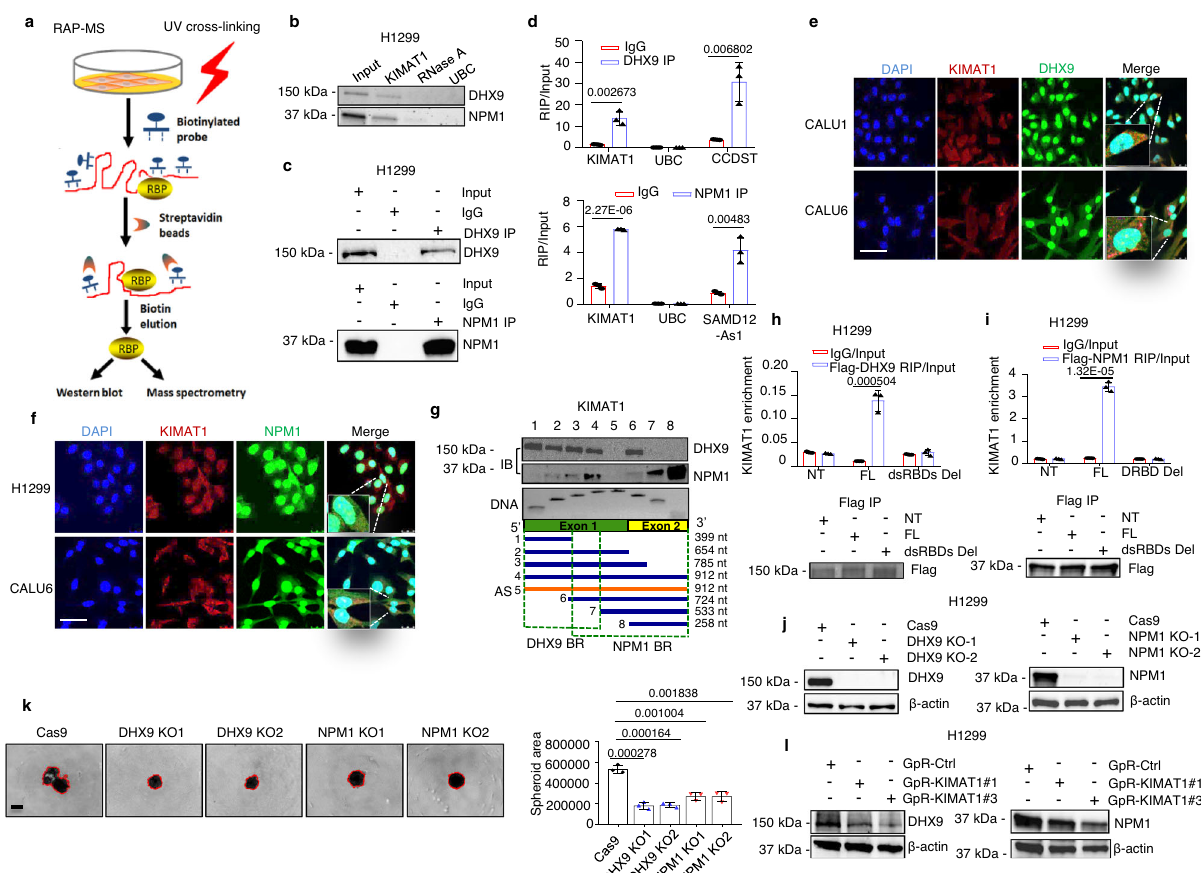
Fig. 4 KIMAT1 directly interacts with DHX9 and NPM1. a Schematic representation of RAP-MS. RBP = RNA-binding protein. b KIMAT1 pull-down with biotinylated antisense probes after UV crosslinking followed by immunoblotting analysis showing that DHX9 and NPM1 are direct KIMAT1 binding partners. A sample treated with RNase A or pull-down of the housekeeping gene UBC were used as negative controls. c Immunoblotting showing DHX9 and NPM1 pull-down ef fi ciency for the experiment in d . d KIMAT1 is enriched by CLIP assay using DHX9 or NPM1 speci fi c antibodies. e , f DHX9 and NPM1 sequential immuno fl uorescence (green) and KIMAT1 smFISH (Red) in different lung adenocarcinoma cell lines. Scale bar, 75 μ m. g Schematic representation of human KIMAT1 , its antisense (AS) and various deletion constructs generated to detect DHX9 or NPM1 binding regions in KIMAT1 sequence. Fragment sizes were con fi rmed by PCR (bottom panel), and binding of each fragment to DHX9 or NPM1 determined via pull-down of biotinylated-labeled RNA fragments and immunoblotting (IB) (top panels) with the indicated antibodies. BR binding region; nt nucleotide. h RNA immunoprecipitation assay. H1299 cells were transfected with FLAG-tagged full-length DHX9 (FL), or DHX9 without the two double-stranded RNA-binding domains (dsRBD Del) or Empty vector (NT), crosslinked and subjected to immunoprecipitation using FLAG-speci fi c antibody. (Top) DHX9-bound KIMAT1 was analyzed by qPCR. (Bottom) Immunoblotting showing immunoprecipitation ’ s ef fi ciency. i RNA immunoprecipitation assay. H1299 cells were transfected with FLAG-tagged full-length NPM1 (FL), or NPM1 without the RNA-binding domain (DRBD Del) or Empty vector (NT), crosslinked and subjected to immunoprecipitation with a FLAG-speci fi c antibody. (Top) NPM1-bound KIMAT1 was analyzed by qPCR. (Bottom) Immunoblotting showing immunoprecipitation ’ s ef fi ciency. j Immunoblotting showing DHX9 KO and NPM1 KO in two different CRISPR/Cas9 clones. k 3D invasion assay and quanti fi cation of the spheroid area in the two DHX9 and NPM1 CRISPR/Cas9 clones in j compared to control cells (Cas9 only). Scale bar, 500 μ m. l immunoblotting showing downregulation of DHX9 and NPM1 upon transfection of H1299 cells with two KIMAT1 GpRs. a , b , e , f , g Representative results or images of two biological replicates. Mean ± S.D ( n = 3). p values were calculated by two-tailed Student ’ s t